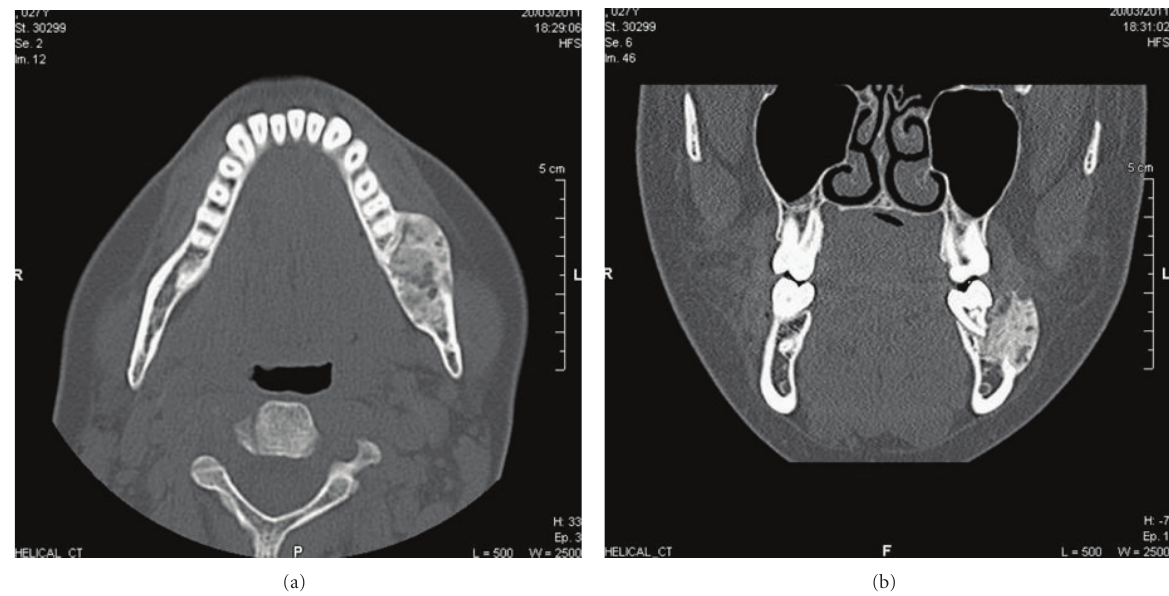
Figure 2: (a) Axial CT of the mandible showing the brown tumour as a mass of the left hemimandible. (b) Coronal CT scan of the brown tumour with well-defined radiolucent osteolytic lesions encircling the roots of